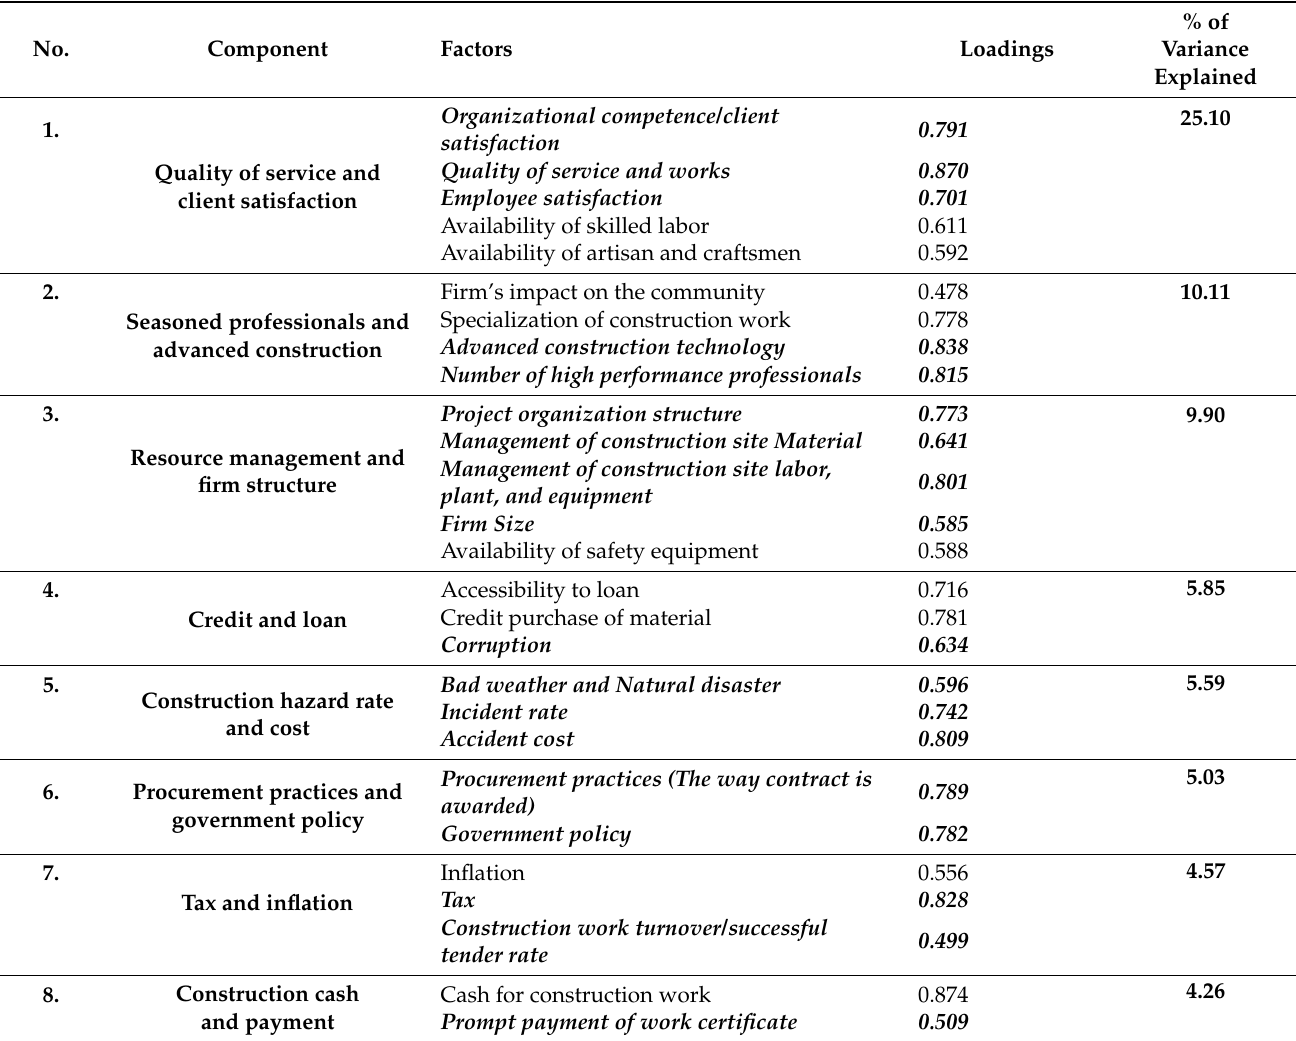
Table 1. The eight named component factors showing variables that can be influenced by BIMadop- tion in